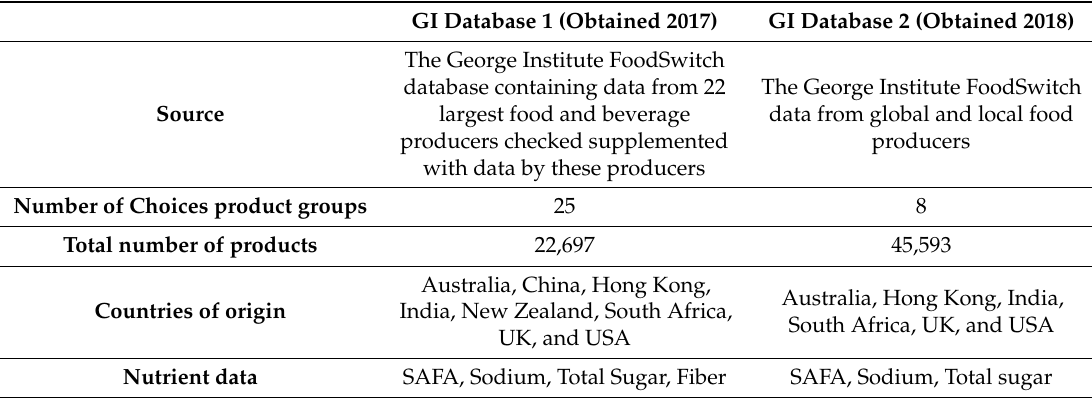
Table 1. Summary of characteristics of GI